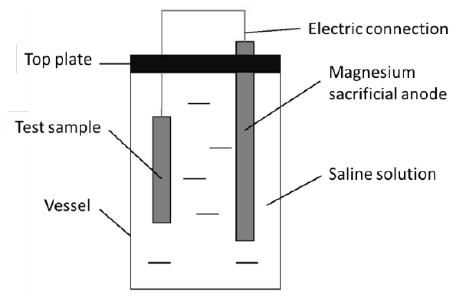
Figure 5. Electrochemical charging scheme.